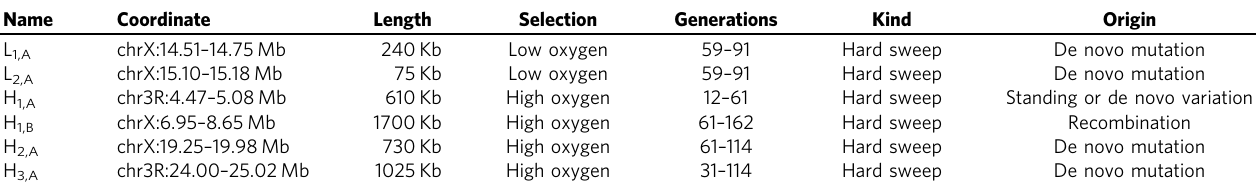
All intervals picked by the adjusted size regime (Coordinate (adjusted)) corresponding to intervals selected by the fi xed size regime (Coordinate ( fi xed)).